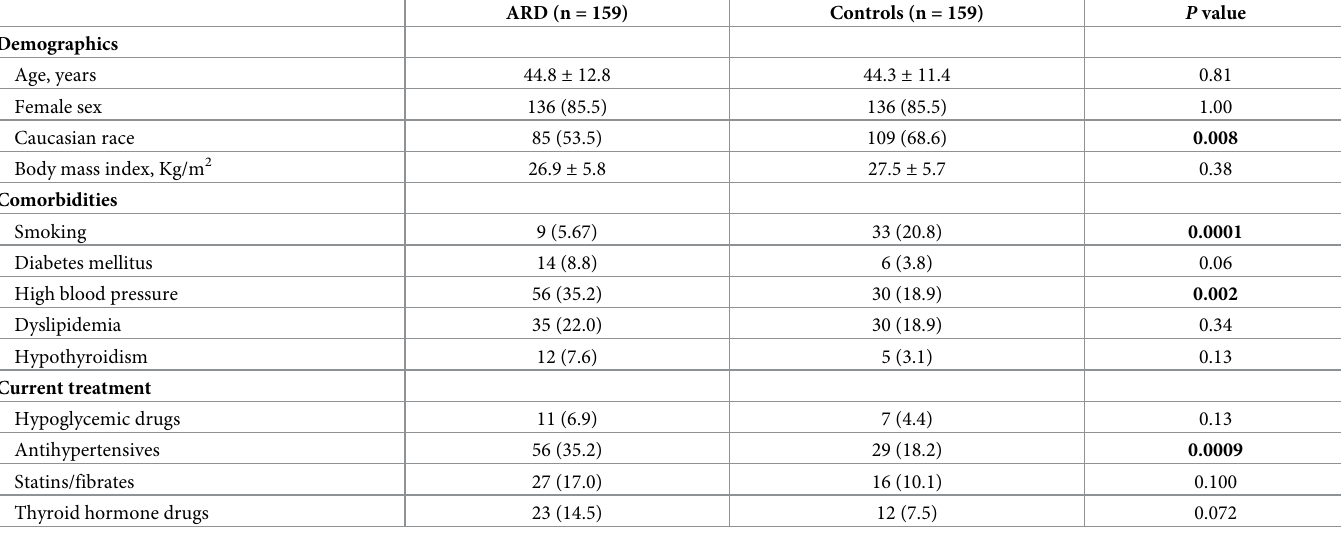
Table 1. Baseline characteristics of 159 autoimmune rheumatic disease (ARD) patients and 159 healthy controls.